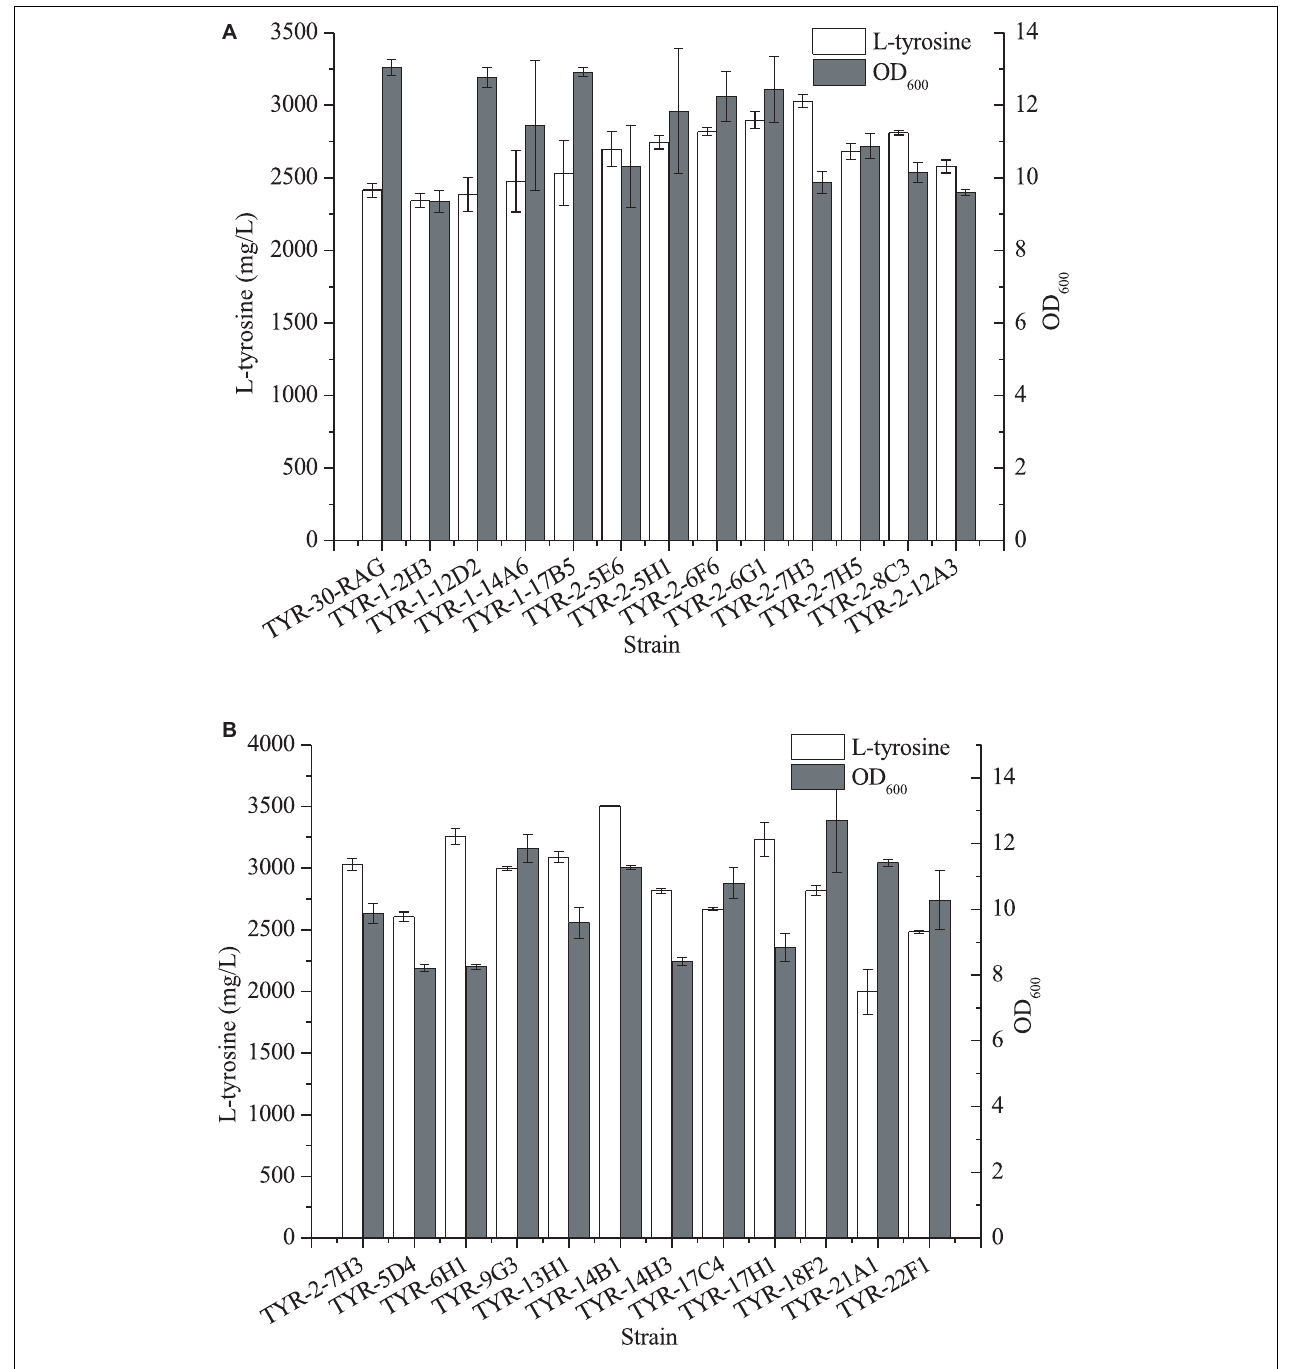
FIGURE 6 | Production of L-tyrosine of the selected E. coli strains after ARTP mutagenesis (A) and error-prone whole genome shuffling (B) . The data represent means of three replicates and error bars represent standard deviations.